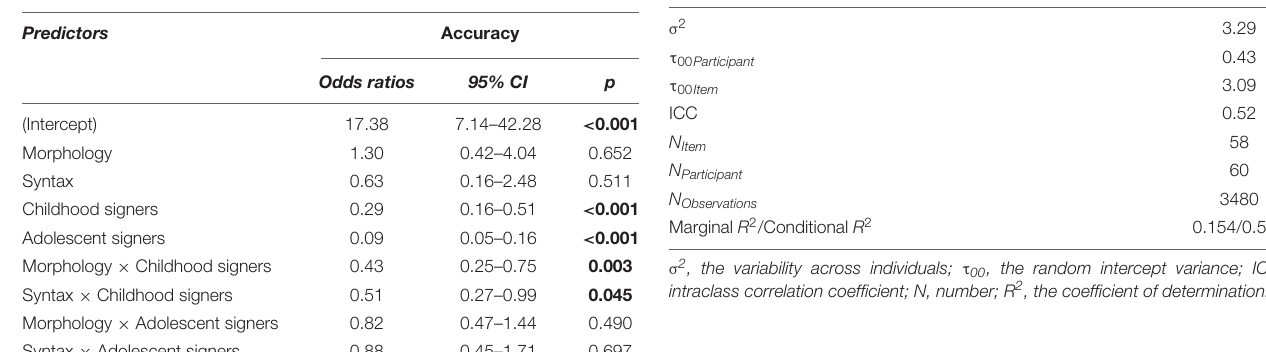
TABLE 3 | The coefficients of a generalized linear mixed-effects two-factor model with fixed effects of language level (phonology, morphology, and syntax) and group (native signers, childhood signers, and adolescent signers) and accuracy as the dependent